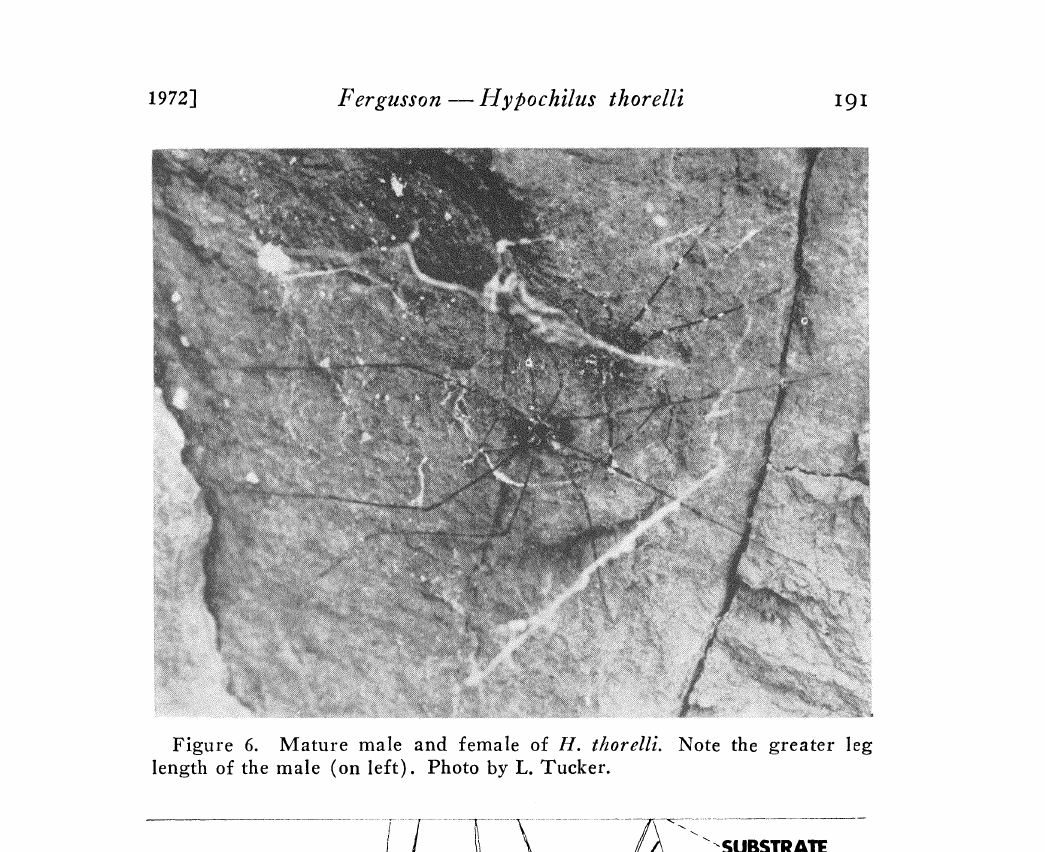
Figure 6. Mature male and female of H. thorelli. Note the greater leg length of the male (on left). Photo by L. Tucker.